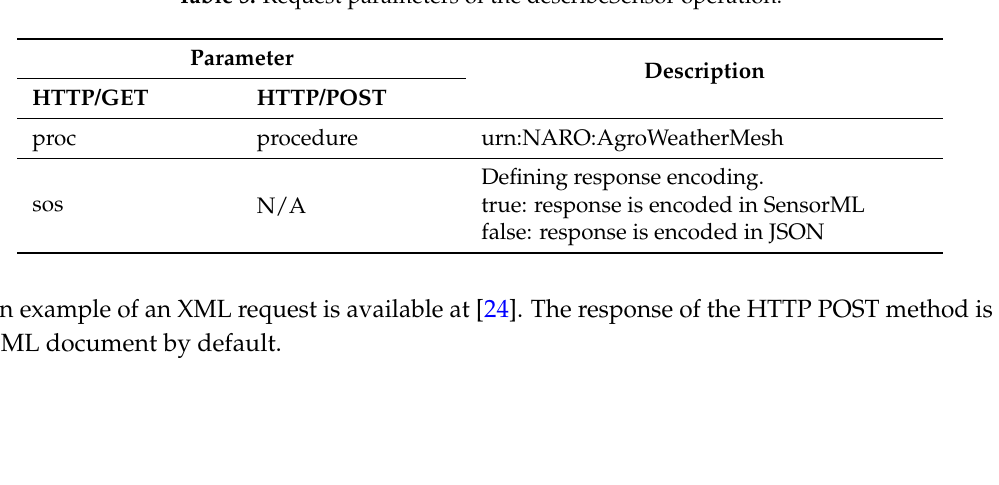
Table 5. Request parameters of the describeSensor